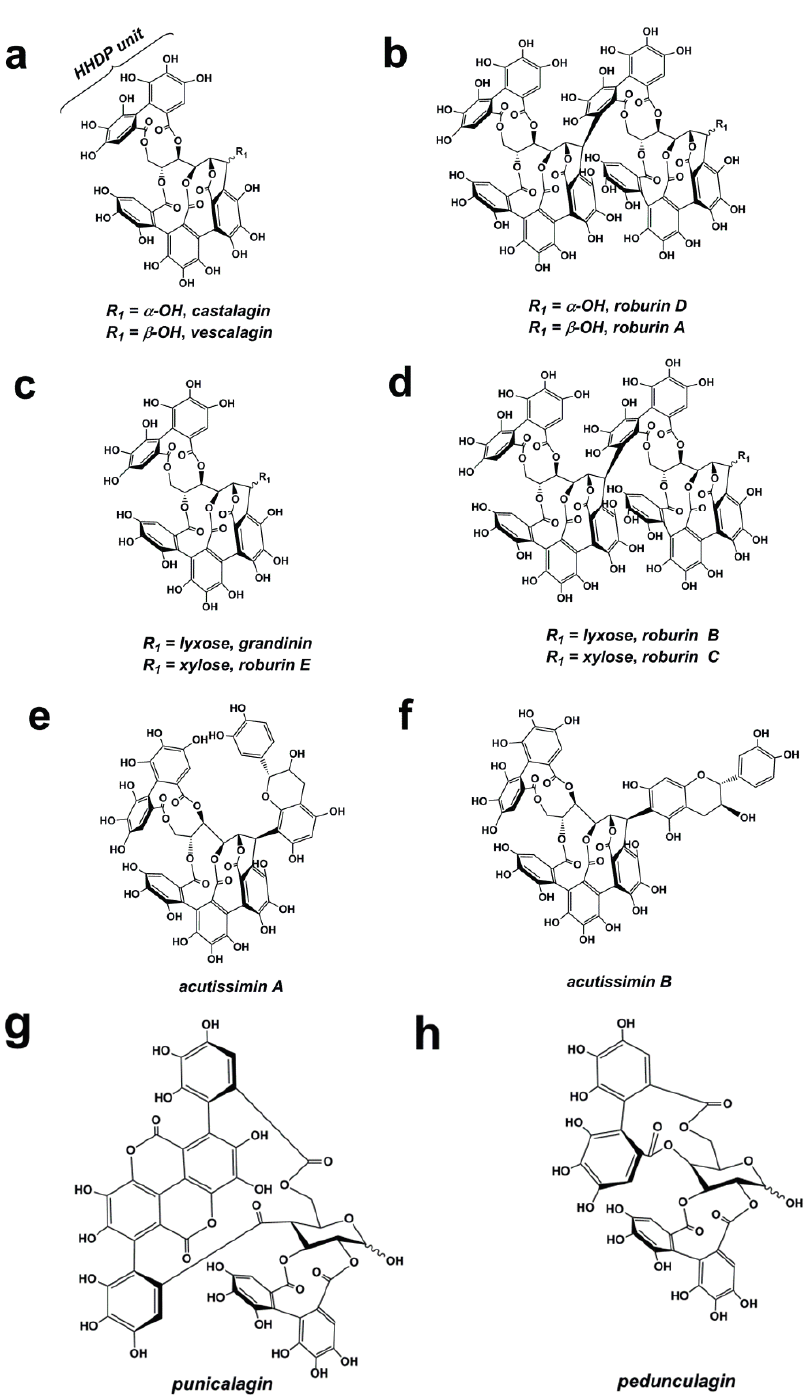
Figure 5. Chemical structures of ellagitannins